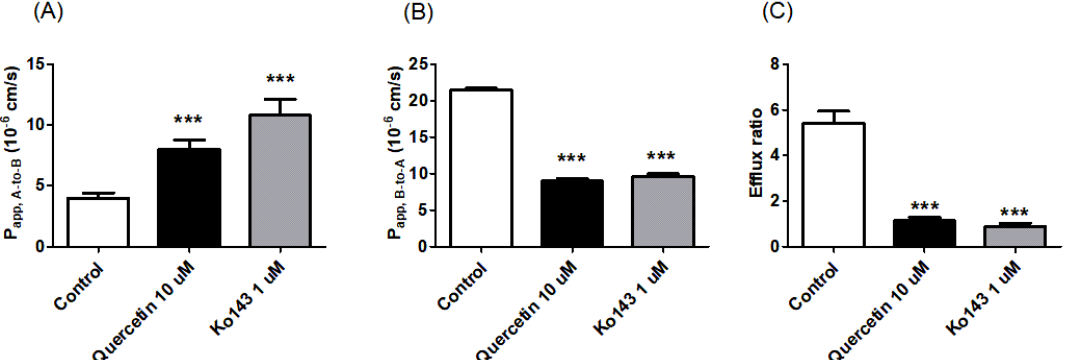
Figure 5. Effect of 10 μ M quercetin or 1 μ M Ko143 on the apparent permeability coefficient and efflux ratio of prazosin, a BCRP substrate, in MDCKII / BCRP cells. ( A ) Apical-to-basolateral apparent permeability coefficient (P app , A-to-B ), ( B ) basolateral-to-apical apparent permeability coefficient (P app , B-to-A ), and ( C ) efflux ratios of prazosin in the absence of inhibitor (i.e., the control) or in the presence of quercetin (10 μ M) or Ko143 (the standard inhibitor of BCRP; 1 μ M). Asterisks indicate statistical differences (* P < 0.05; ** P < 0.01; and *** P < 0.001) from the control group (i.e., without the inhibitor) according to one-way ANOVA, followed by Tukey’s post hoc test. Data are presented as the mean ± SD of triplicate runs.